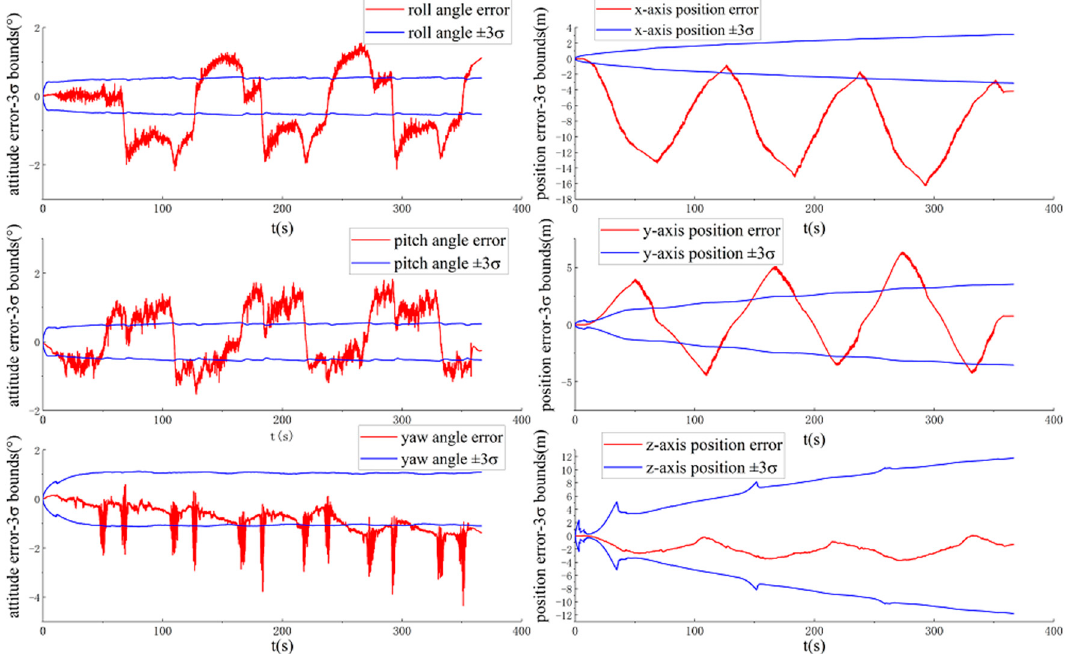
Figure 7. The ground-truth pose errors and estimated ± 3 σ bounds of ACK-MSCKF(4) with time for the VD06 dataset.